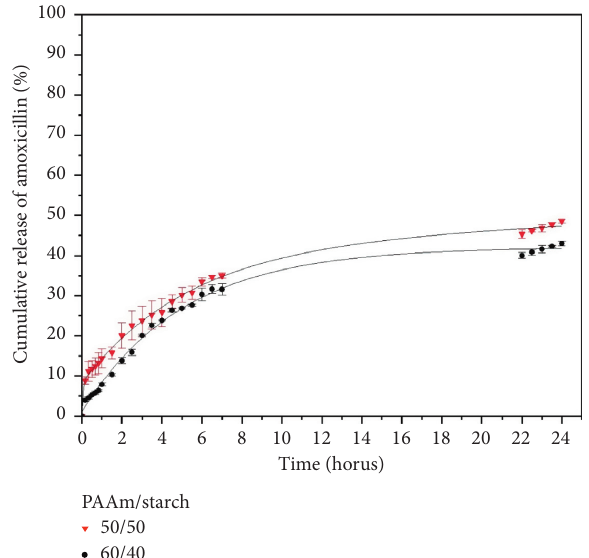
Figure 10: Cumulative release of amoxicillin from composite hydrogels PAAm/starch 60/40 and 50/50 in PCA, pH 3.0 at 25 ° C. The error bars represent the standard deviation ( n �